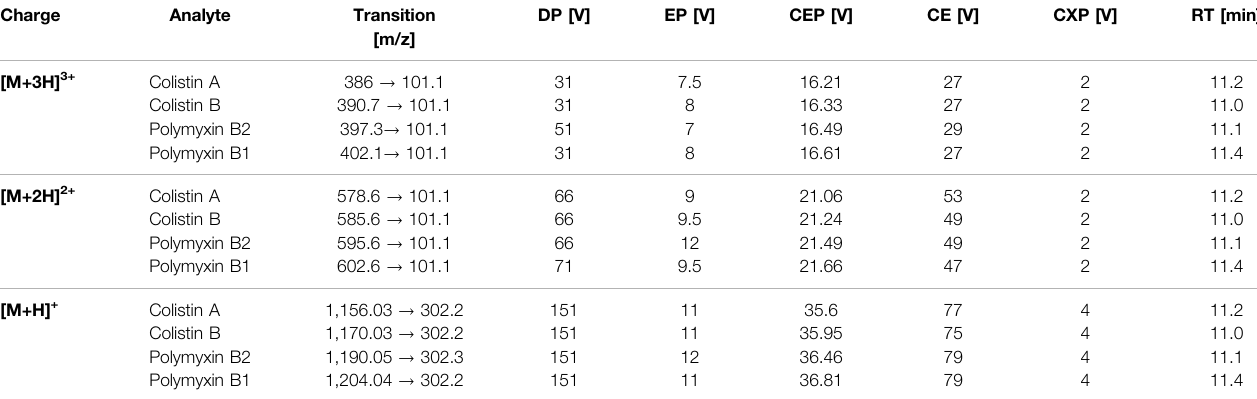
TABLE 1 | LC-MS/MS parameters for MRM detection of polymyxin B1, polymyxin B2, colistin A, and colistin B, including mass transitions for the triple [M+3H] 3+ , double [M+2H] 2+ and single [M+H] + charge ions; declustering potential (DP), entrance potential (EP), collision entrance potential (CEP), collision energy (CE), cell exit potential (CXP), and retention time